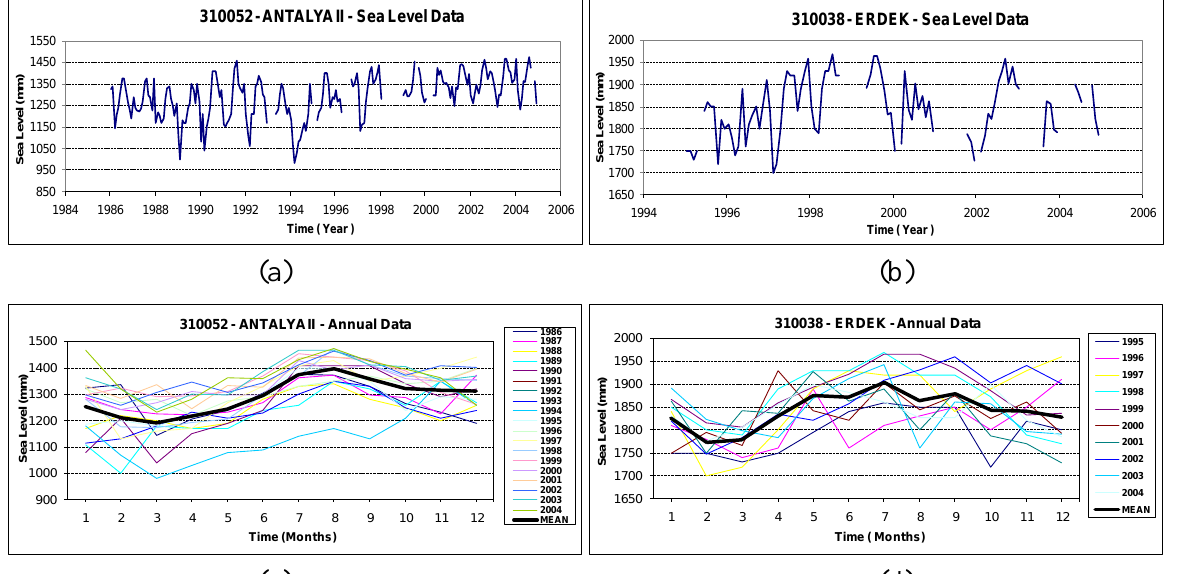
Figure 4. The sea-level data of Antalya-II and Erdek tide gauges for the considered time span: (a, b) the entire data span, (c, d) the annual changes of sea level and their